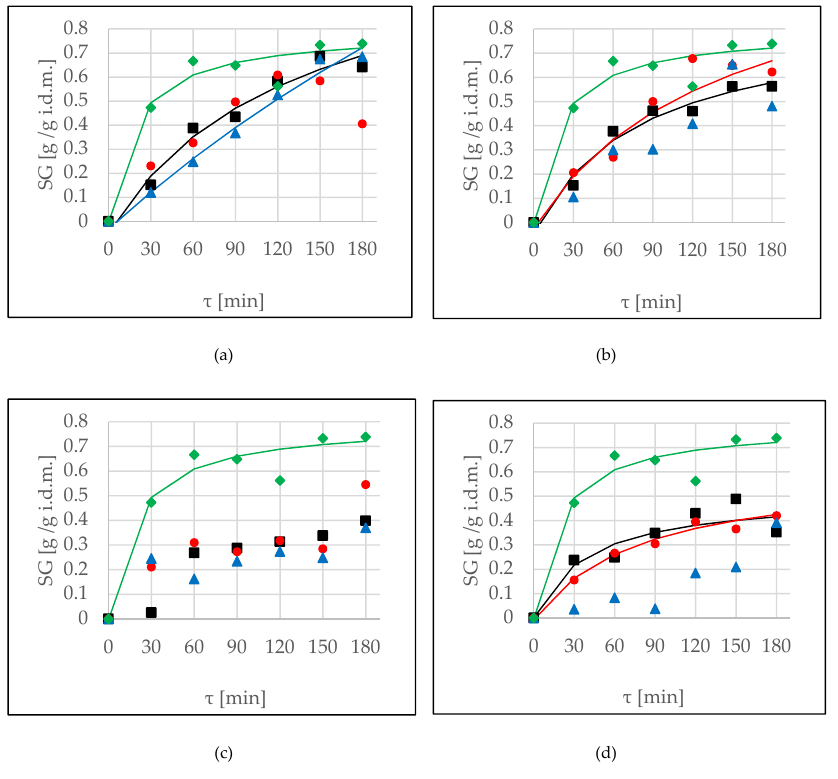
Figure 2. Solid gain (SG) kinetics at several conditions, (OD ( ■ ), OD+US ( ● ), OD+USi ( ▲ )) at 40 °C, in different solutions: ( a ) erythritol, ( b ) xylitol, ( c ) maltitol, ( d ) DHA. Lines represent the Peleg’s model. The green line ( ♦ ) is the kinetic reference (sucrose). Table 5. The influence of osmotic agents and pre-treatment time on solid gain during OD.